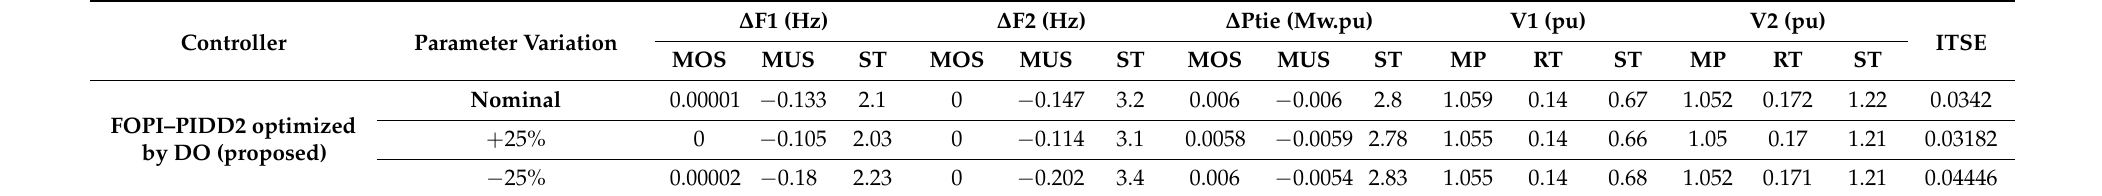
Table 12. Dynamic response specifications under the effect of ± 25% variation in system